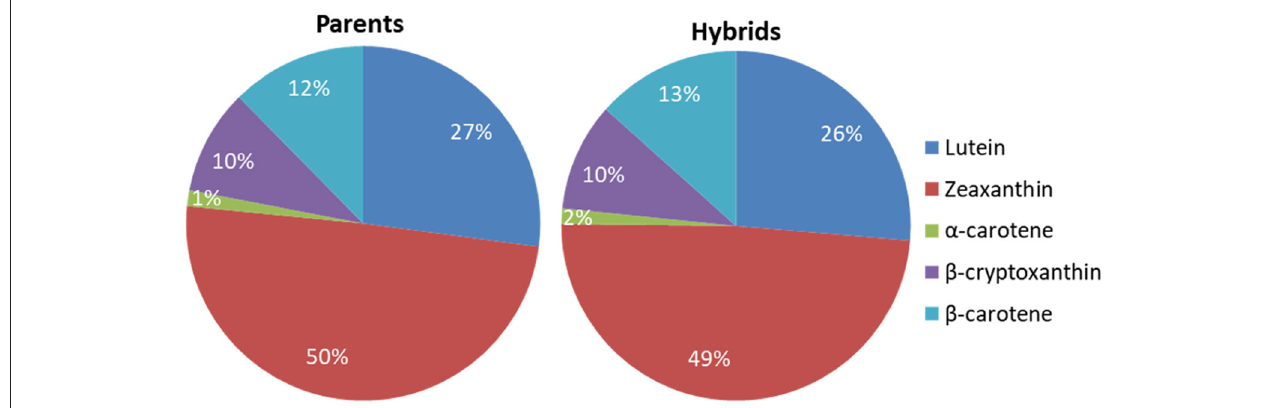
FIGURE 1 | Proportions of the carotenoids in the endosperm of the parental inbred lines and the F1 hybrids averaged across environments.